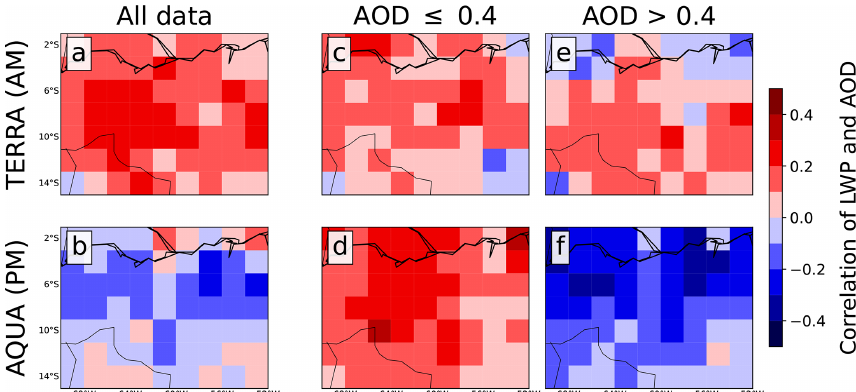
Figure 5. Pearson’s correlation coefficient between LWP and AOD. The top row (a, c, e) shows the TERRA overpass in the morning, and the bottom row (b, d, f) shows the AQUA overpass in the afternoon. The left column (a, b) shows the spatial distribution of the coefficient for all data, the middle column (c, d) shows data for AOD ≤ 0.4, and the right column (e, f) shows data for AOD > 0.4. Red colours depict a positive correlation, and blue colours depict a negative